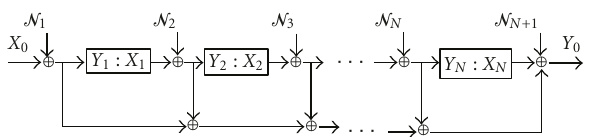
Figure 3: A degraded chain network with additive noises N k , 1 ≤ k ≤ N , [13, Figure